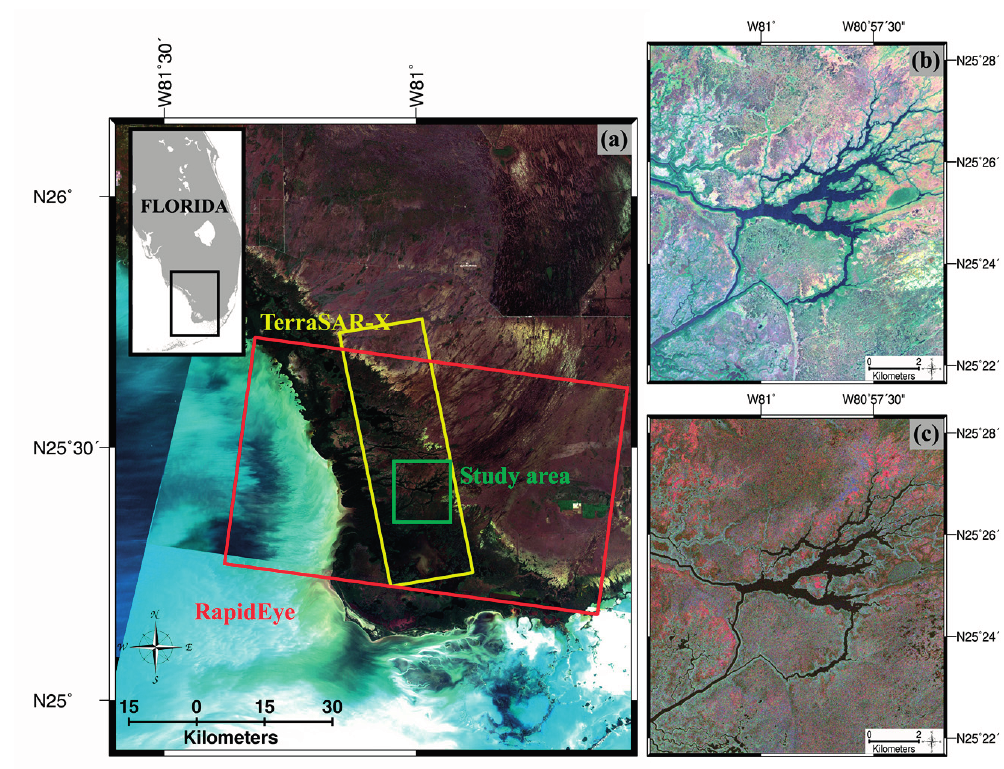
Figure 1. ( a ) Location of the study area in the western Everglades, shown with a Landsat ETM+ image rendered as a true-color composite [39]. The frames mark the swath locations of data acquired by X-band TerraSAR-X SAR (16 April 2010) and RapidEye optical (3 December 2010) satellite. The green frame indicates the location of main study area. ( b ) RapidEye multispectral true-color composite image over the study area. ( c ) Pauli decomposition of TerraSAR-X SAR image as a color composite image: HH-VV (red), HH+VV (blue), and HV